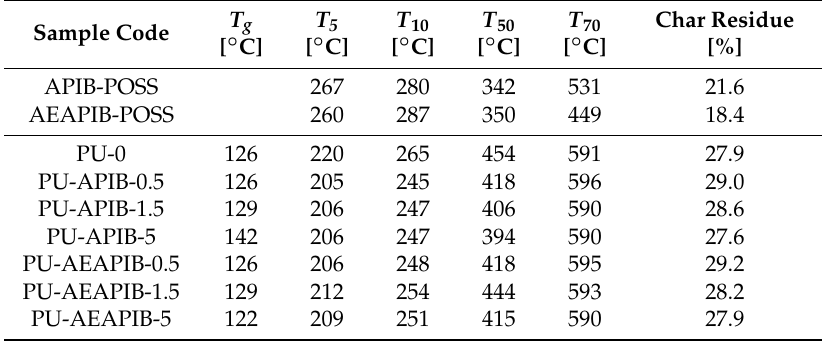
Table 3. The results of thermogravimetric analysis of RPUFs.